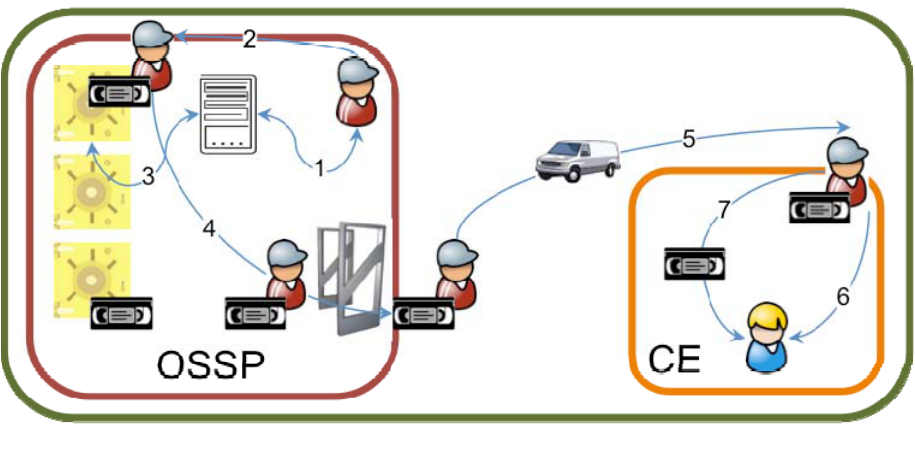
Figure 2. Custody unit delivery